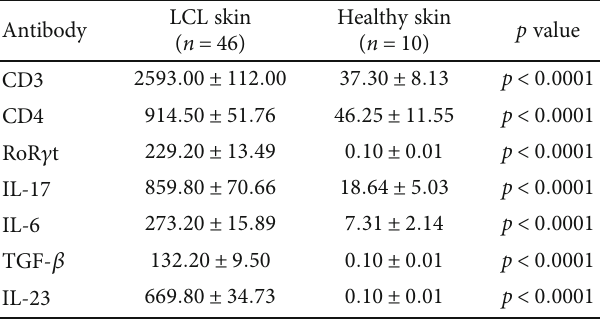
Table 1: Mean and standard error of the cellular densities (cells/mm 2 ) of the di ff erent markers used to evaluate the Th17 immune response in the skin lesions of the patients with localized cutaneous leishmaniasis (LCL) caused by L. ( V. ) panamensis and in healthy